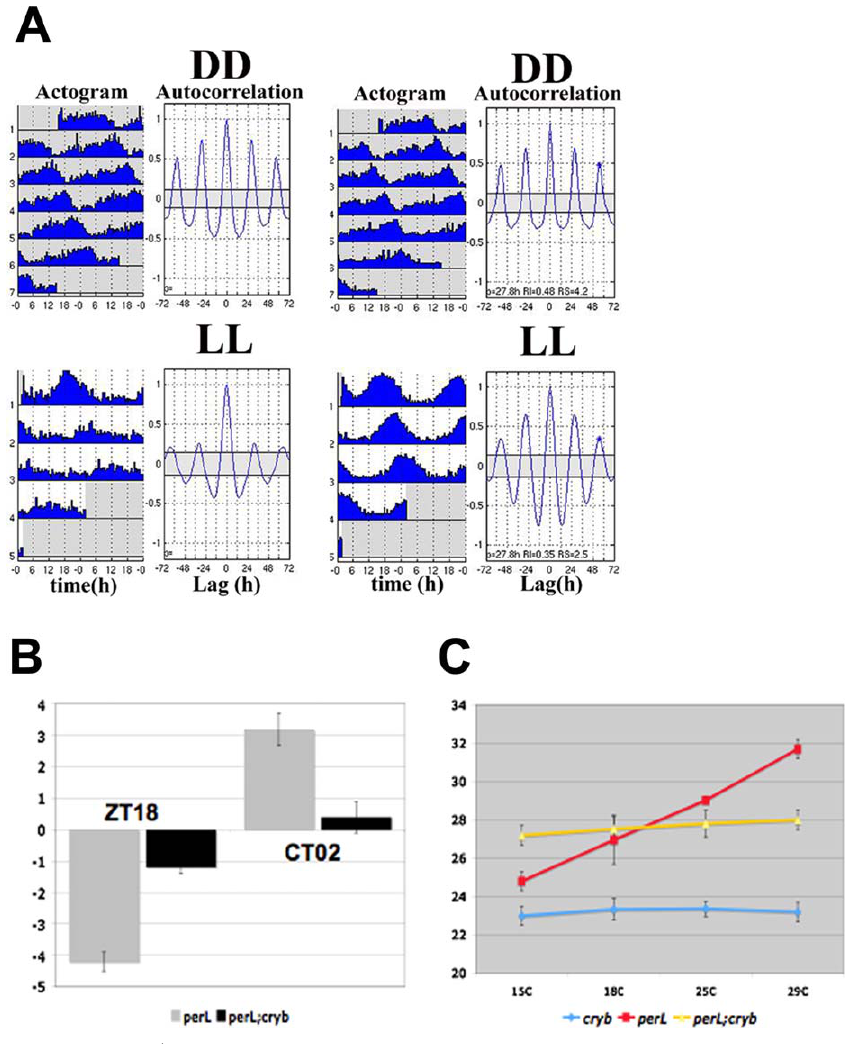
Figure 5. per L ; cry b Flies Show Reduced Heat Phase Shifts and Better Temperature Compensation (A) Behavior in DD and LL cycles was monitored for per L and per L ; cry b flies. The data were collected at a constant temperature of 25 8 C. The average activity plots for 16 flies are shown. Adult male flies of 1–3 d old were entrained for 3 d (12 h: 12 h LD) and released in DD (as indicated by shading throughout the actogram in the left columns for each genotype) for 6 d followed by LL (as indicated by lack of shading throughout the actogram in the left columns for each genotype) for 4 d. Within each actogram, a given row shows two consecutive days of activity; the second such day is replotted in the left half of the next row down (thus, consecutive days of locomotion can be viewed both horizontally and vertically); heights of bars within a given actogram row reflect varying amounts of locomotion per half hour data collection bin. In the column next to the actograms, autocorrelation plots for these behavioral records are shown. The autocorrelation plot indicates rhythmicity and gives a measure of rhythm intensity (RI). In LL, the per L flies become arrhythmic after 1 d; per L ; cry b remains rhythmic. The data were analyzed as described in Materials and Methods [46]. For details on autocorrelation, also see Material and Methods. (B) Phase response to 37 8 C heat pulse in per L and per L ; cry b flies. Left and right panels show the phase changes observed at ZT18 and CT02, respectively. On the x -axis, the Zeitgeber 37 8 C heat pulse is shown. Phase delays and advances are calculated as described in Figure 1A and are plotted on the y- axis ( 6 SEM) as negative and positive values, respectively. For each genotype, an average phase shift from 15–32 flies is shown. (C) Period in hours was calculated for cry b (circle and blue), per L (squares and red), or per L ; cry b (diamonds and yellow) at 15 8 C, 18 8 C, 25 8 C, and 29 8 C in constant darkness. The average period is determined from three independent experiments. For each experiment, the average period was calculated using MESA for individual flies and then combined to obtain an average period length. For details on MESA, see Materials and Methods section. The average period (T) and SEM of the period (in hours) are as follows: 15 8 C cry b (23, 0.5), 15 8 C per L (24.8, 0.5), 15 8 C per L ; cry b (27.2, 0.5), 18 8 C cry b (23.3, 0.58), 18 8 C per L (26.9, 1.2), 18 8 C per L ; cry b (27.5, 0.6), 25 8 C cry b (23.3, 0.3), 25 8 C per L (29.02, 0.2), 25 8 C per L ; cry b (27.8, 0.7). 29 8 C cry b (23.3, 0.5), 29 8 C per L (31.7, 0.5), 29 8 C per L ; cry b (28, 0.5). Period lengths for the three genotypes at a given temperatures were found to be significantly different